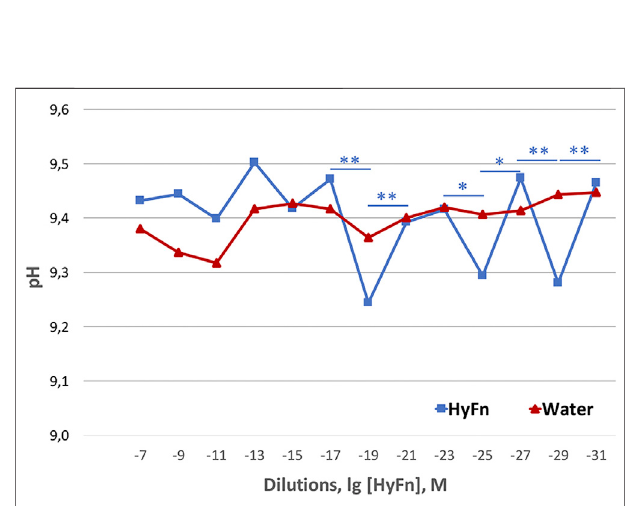
FIGURE 6 | Averaged over all experimental series pH values in HyFn dilutions (blue curve) and “ dilutions ” of water (red curve) after the 15th NaOH injection into HyFn dilutions samples and corresponding water “ dilutions ” samples. Red line indicates control water “ dilutions, ” and blue line – dilutions of HyFn. Abscissa depicts sequential dilutions corresponding to calculated lg [HyFn], M. Blue bars above the blue curve designate statistically signi fi cant differences of pH values in neighboring HyFn dilutions according to Mann-Whitney U test: ** p < 0,01; * p < 0,05.